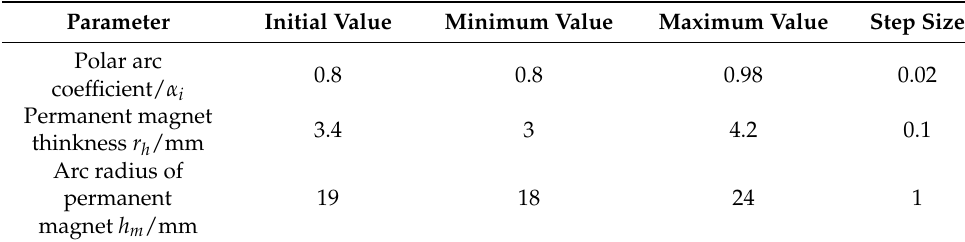
Table 3. Parameter variables to be scanned optimization variables.